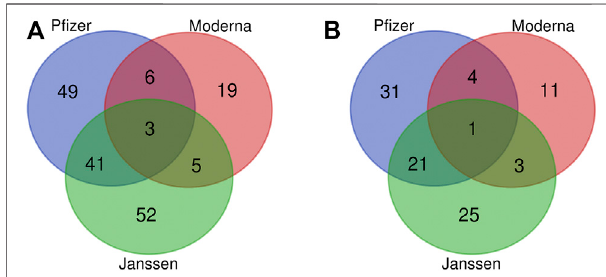
FIGURE 1 | Venn diagram of signi fi cant AEs associated with the Janssen, Moderna, and P fi zer vaccines. (A) Non-trimmed version of 175 AE terms. (B) Trimmeddataof96AEtermsafterremovingnon-medicallyrelevant AEs. The criteria for signi fi cance selection included Chi-square statistic > 4, PRR > 2, and case report frequency >